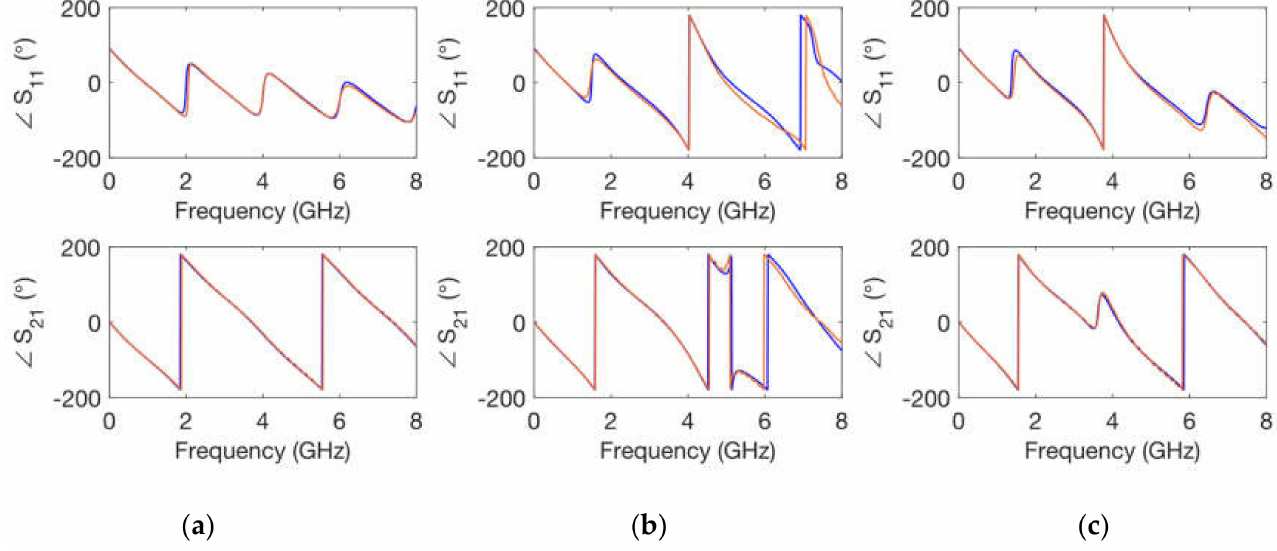
Figure 7. Simulated ( blue ) and measured ( orange ) calibrating elements phase of scattering parame- ters for a h = 1 mm substrate height. ( a ) transmission line; ( b ) short stub; ( c ) long